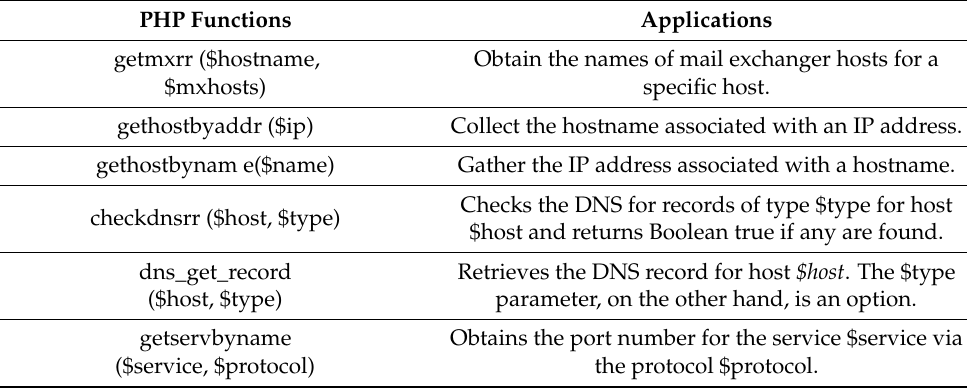
Figure 4. Raw data downloaded by Twitter scraper. Table 1. PHP functions and their